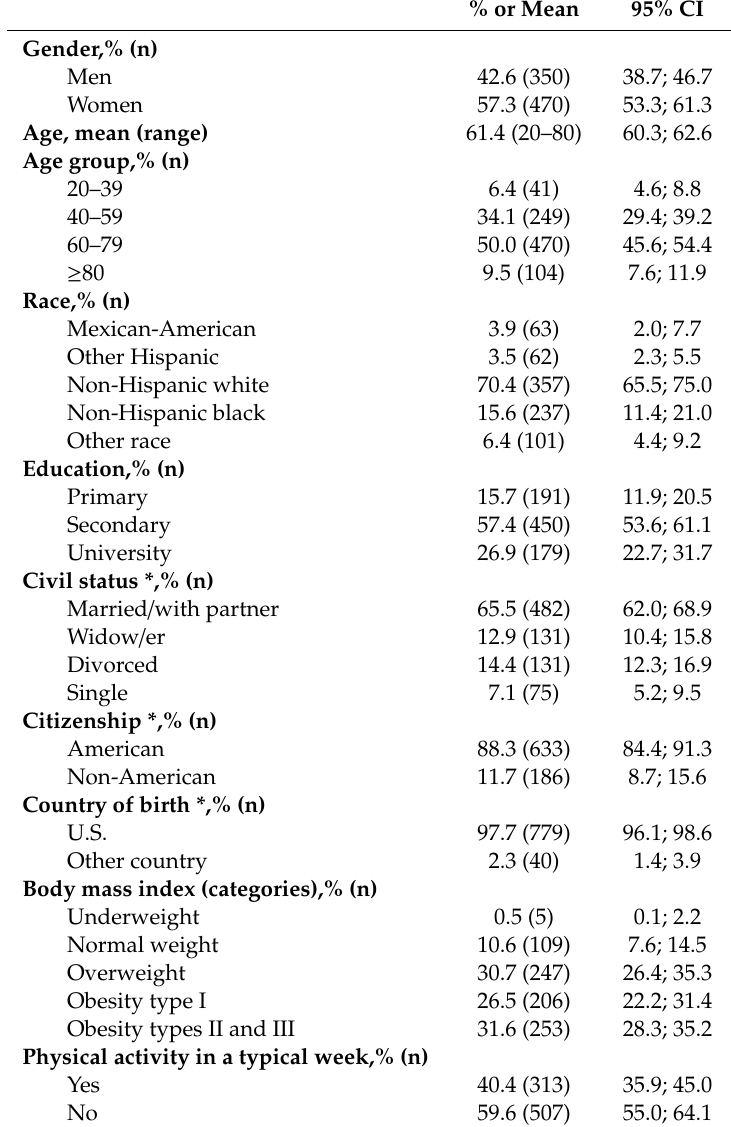
Table 2. Sociodemographic characteristics of the sample (n =